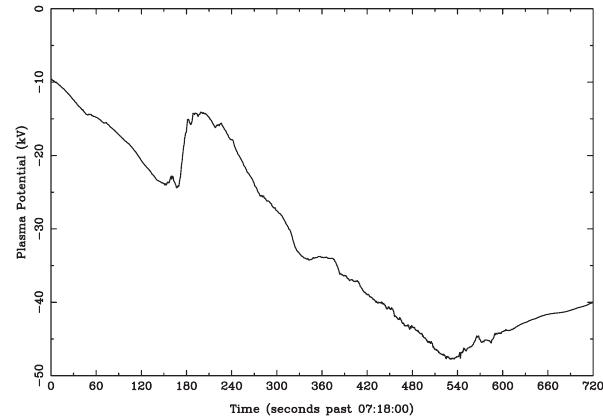
Fig. 5b. A plot of the integral of R E · d L along the Polar spacecraft Figure 5b trajectory. At least three regions of field reversal are